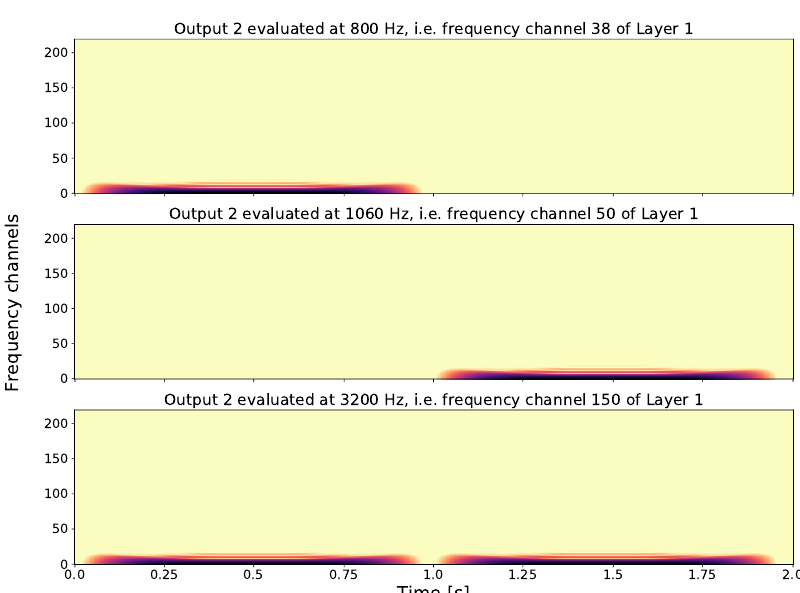
Figure 4. Output 2 of two tones with different fundamental frequencies, at different fixed frequency channels of Layer